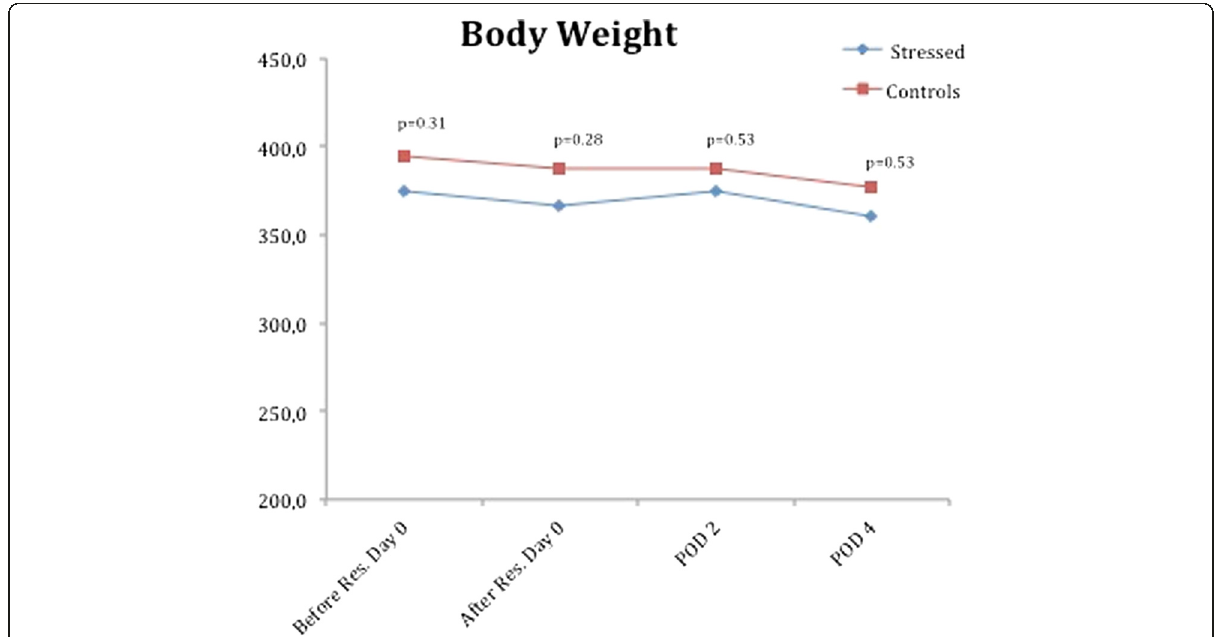
Fig. 3 Body weight. Mean body weight for each group of animals. The blue line marks the treatment group and the red line marks the control animals